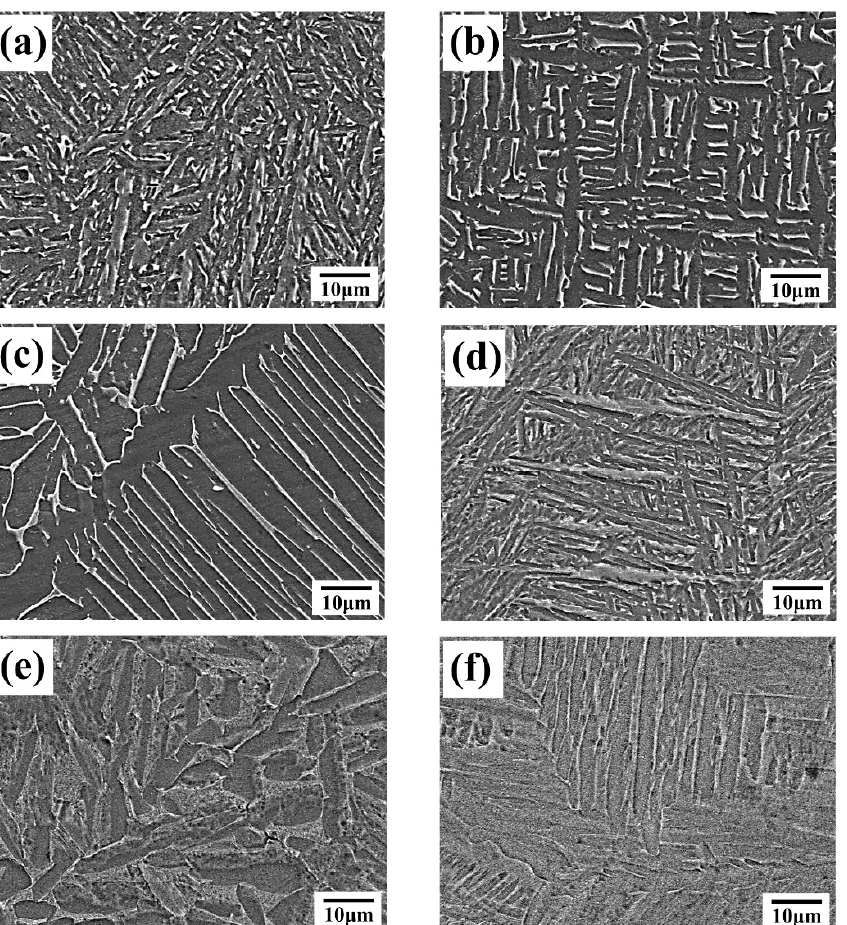
Figure 5. Representative microstructures (SEM) of Ti6Al4V specimens following heat treatment schedules ( a ) 850FC, ( b ) 950FC, ( c ) 1050FC, ( d ) 850WAC, ( e ) 950WAC, ( f ) 1050WAC.